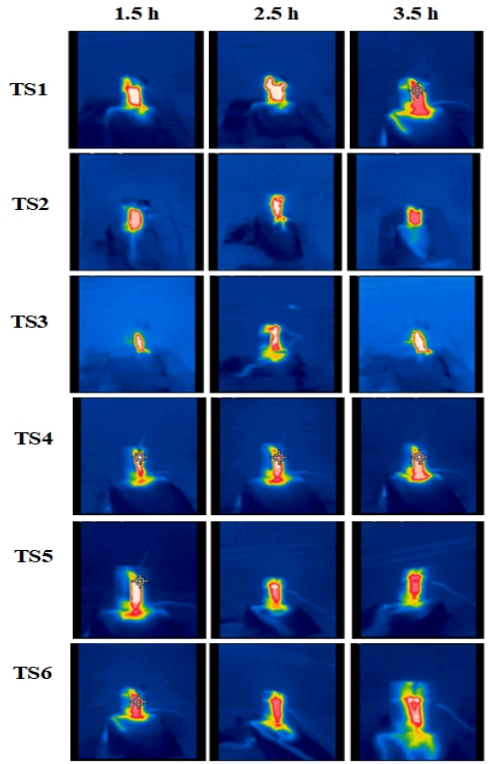
Figure 11. Infrared thermograph of the unaged samples from TS1 to TS6.